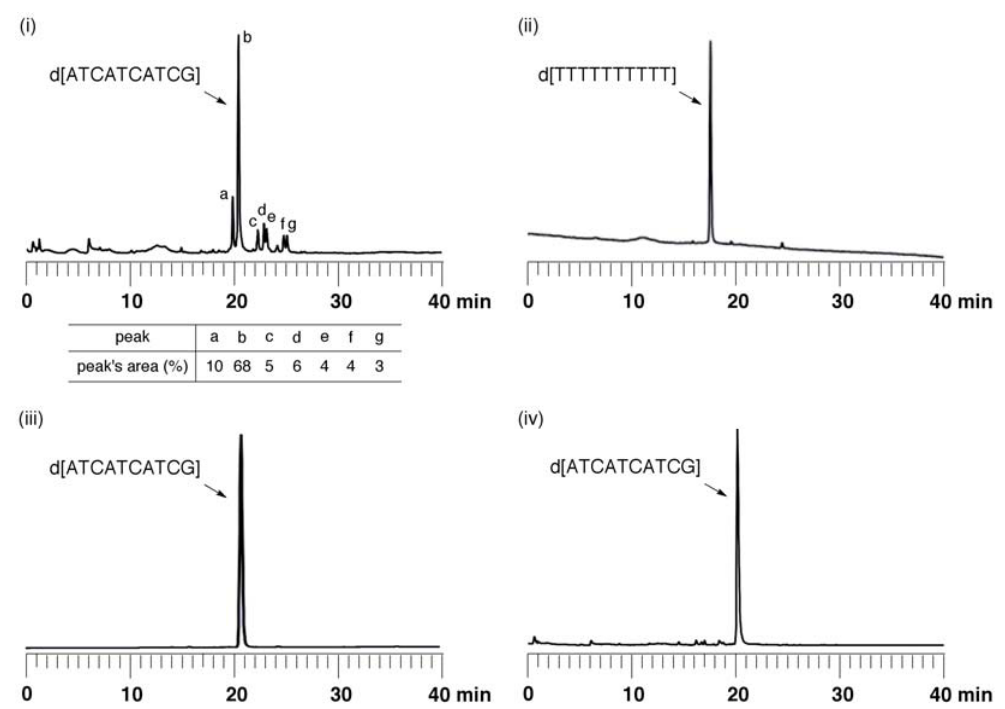
Figure 4. Anion-exchange HPLC profiles of ODNs obtained by using (i) the fully protected monomers (T Bz , C phth , A phth , and G i Bu·dibe ); (ii) only T Bz monomer and (iii) T Bz , C phth , A phth , and G i Prpac monomers after removal of the cyaonoethyl groups of the internucleotidic phosphate groups by treatment with DBU-CH (iv) Anion-exchange HPLC profile of deprotection of ODN having the fully